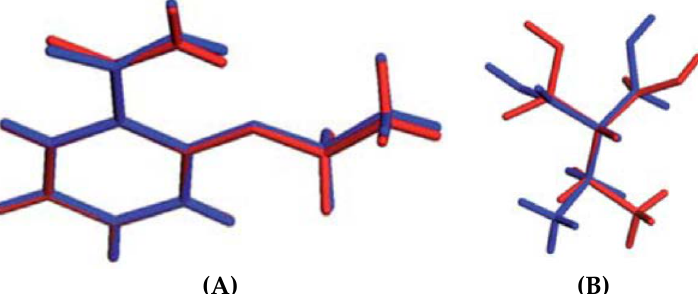
Figure 28. Overlay of conformers of ethenzamide (in left) and ethylmalonic acid (in right) in ( A ) form 1 (in red) and ( B ) form 2 (in blue) cocrystal ([Reprinted from [216] with permission. Copyright 2010 Royal Society of Chemistry].